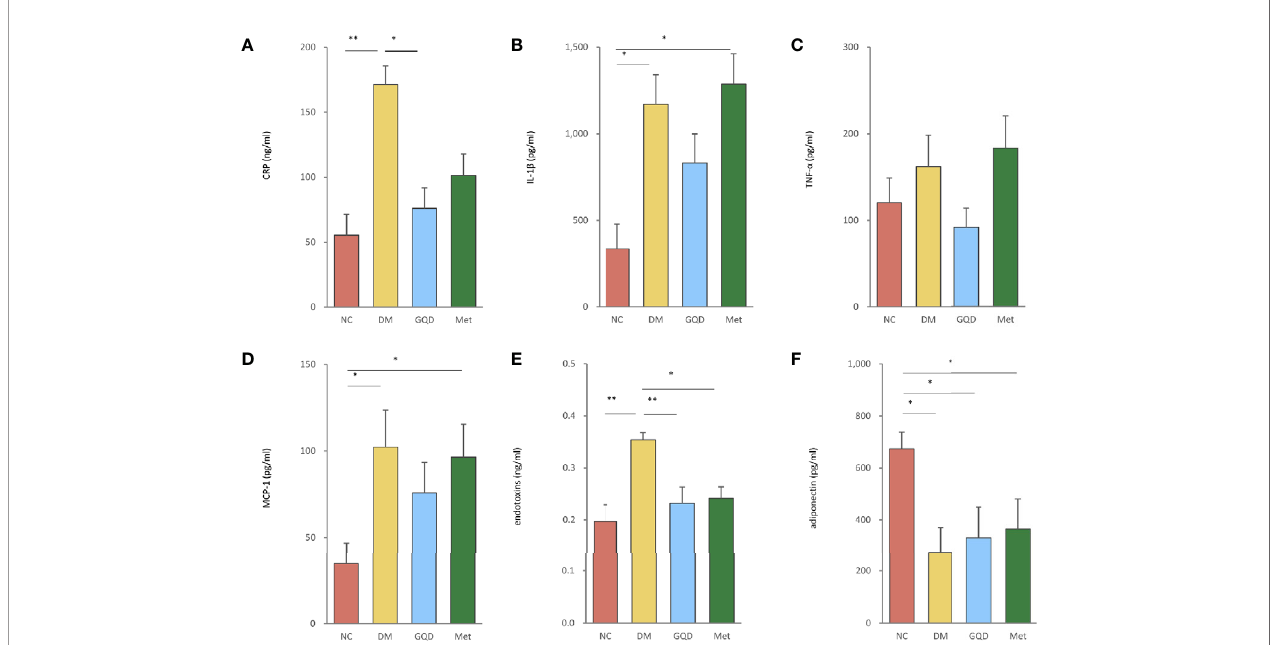
FIGURE 3 | GQD inhibited in fl ammation of T2DM rats by regulating the levels of serum in fl ammatory factors. The serum levels of (A) CRP, (B) IL-1 b , (C) TNF- a , (D) MCP-1, (E) endotoxins, and (F) adiponectin after treatment for 12 weeks. Values are expressed as means ± SE. Differences were assessed by ANOVA: **p < 0.01, *p < 0.05. CRP, C-reactive protein; IL-1 b , interleukin-1 b ; TNF- a , tumor necrosis factor- a ; MCP-1, monocyte chemoattractant protein-1.